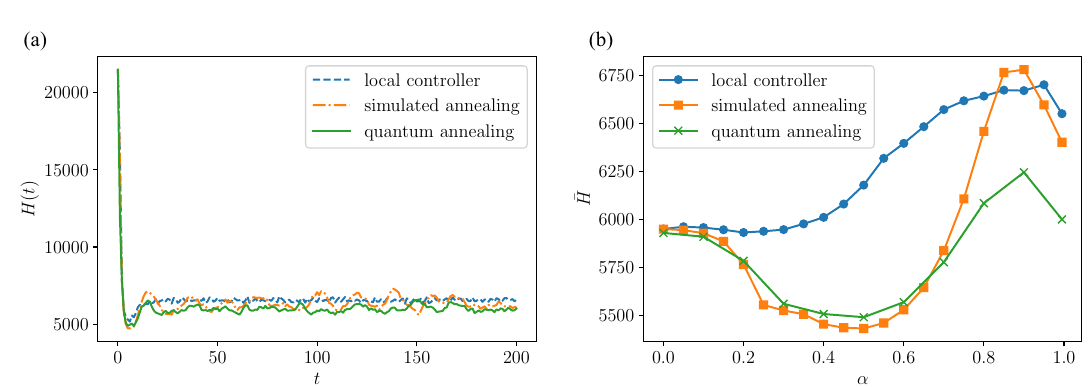
Figure 3. Hamiltonian of Eq. (10) under different control methods. ( a ) Time evolution of the Hamiltonian, where the parameters α , η , and L are fixed as α = 0.8, η = 1.0 , and L = 50 , respectively. ( b ) Time average of Hamiltonian as functions of α , where the parameters η and L are the same as those in ( a